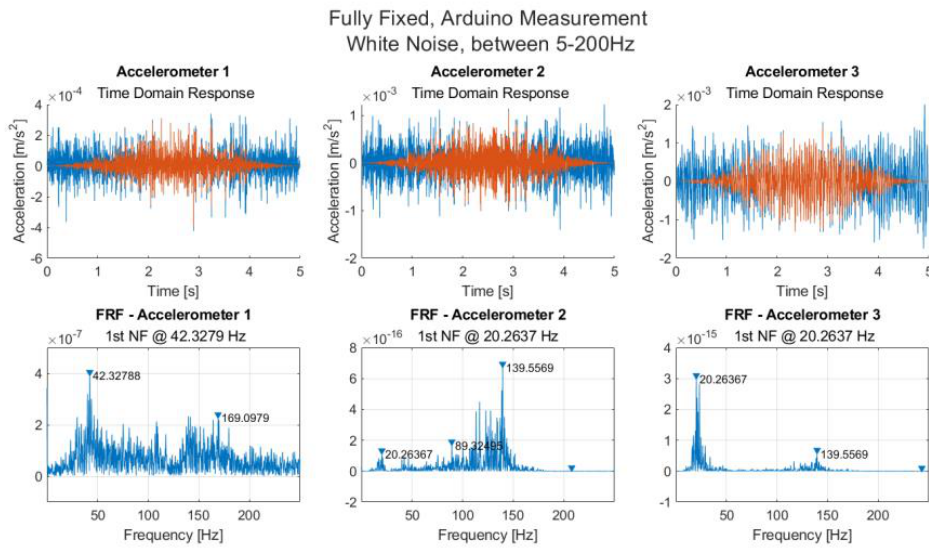
Figure 9. Time domain measurements along with measured FRFs from accelerometers 1, 2 and 3 for white noise excitation using an Arduino Due.